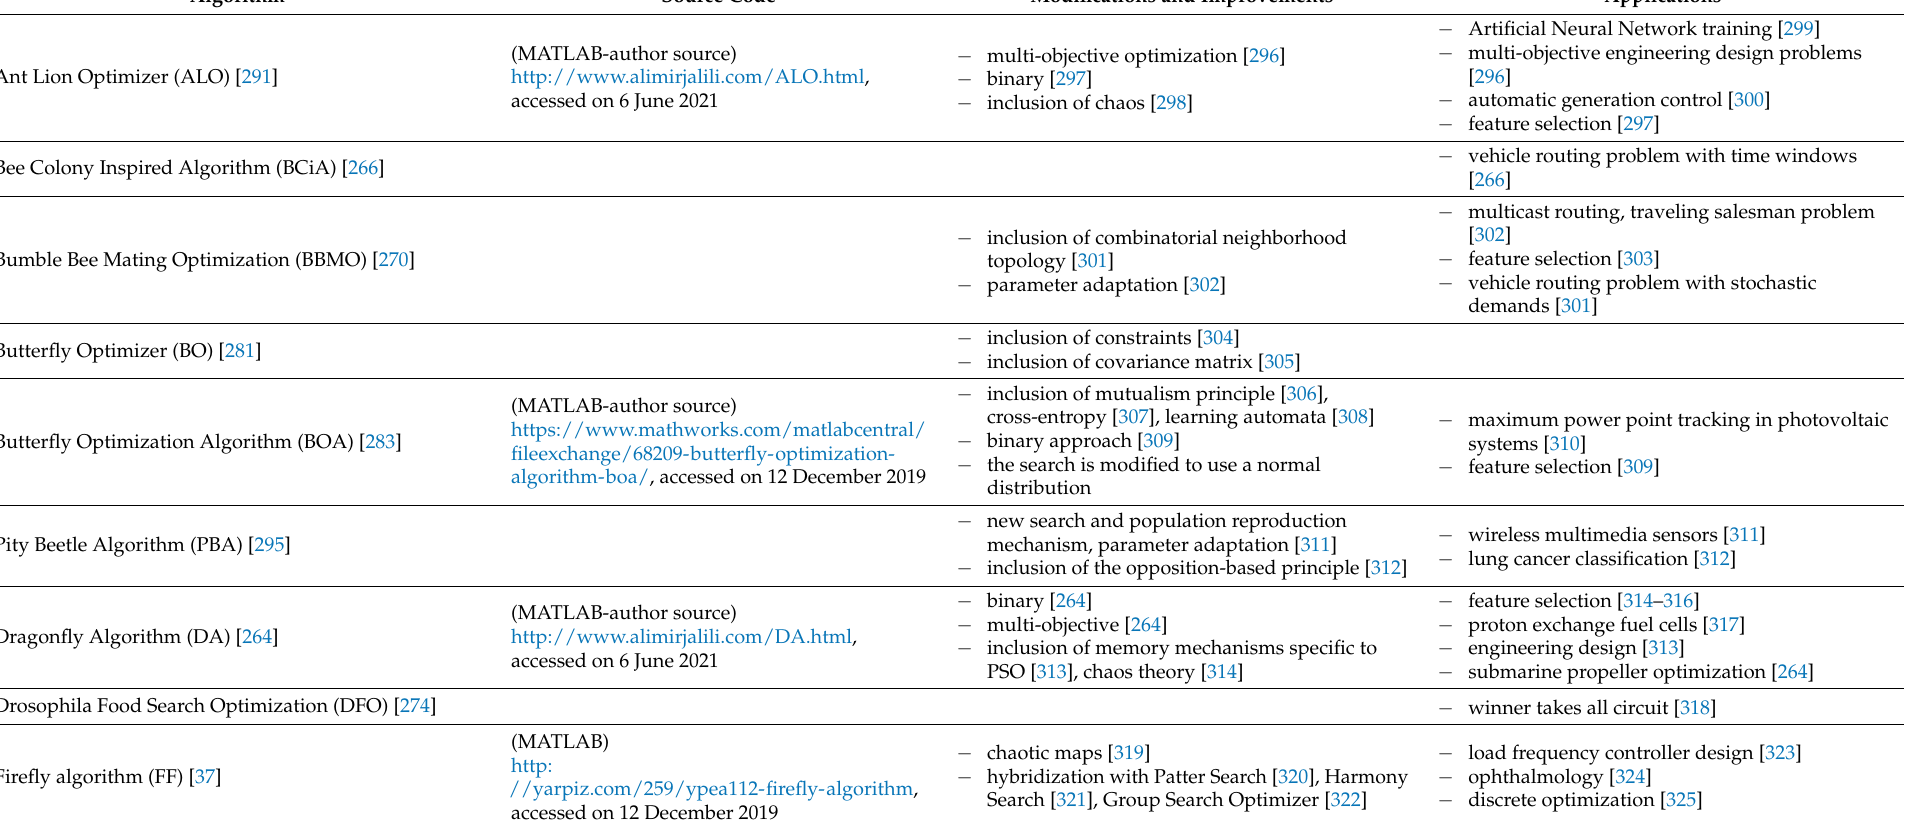
Table 4. Improvements and applications for insect-inspired metaheuristics (alphabetically